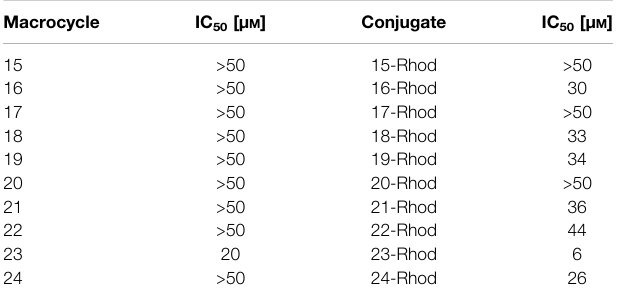
TABLE 2 | IC 50 values of the macrocycles 15 – 24 as well as their conjugates 15- Rhod to 24-Rhod.